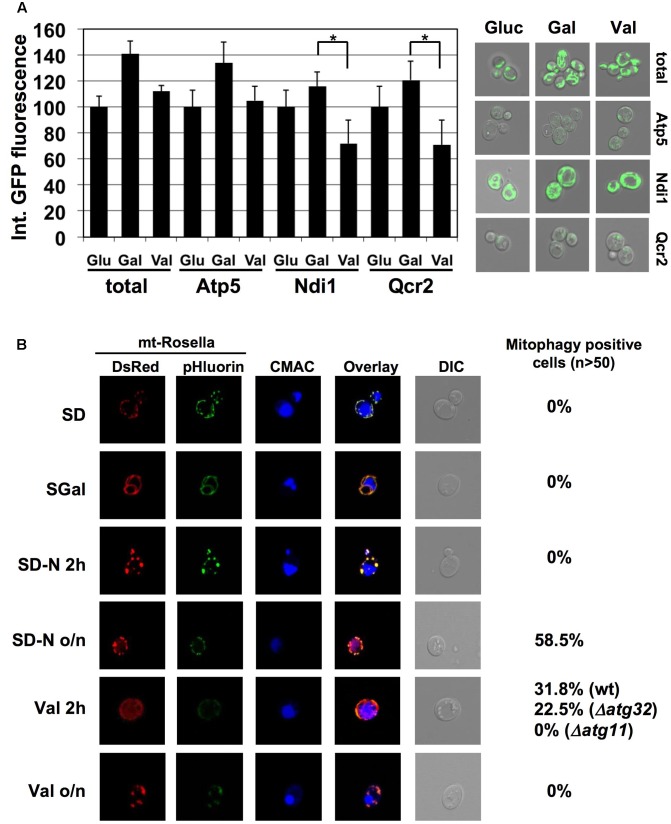
Valinomycin damage induces ETC specific mitophagy in yeast. (A) GFP fluorescence from the indicated ETC subunits or from mt-GFP was quantified upon fermentative growth (Glu) or partially respiratory growth without (Gal) or after treatment for 2 h with 4 μM valinomycin (Val). The mean of the integrated fluorescence intensity acquired from flattened z-stack images for >50 cells was calculated in one experiment. Data are shown as mean values and the standard error from two independent experiments. Asterisks mark a significant signal reduction (p < 0.05) according to the Students t-test. Representative micrographs are depicted at the right. (B) Valinomycin rapidly induces mitophagy in yeast cells. The mitophagy indicator Rosella was used in the indicated yeast strains. Cells were grown in selective glucose containing (SD) or galactose containing (SGal) media. Galactose grown cells were additionally subjected to N-starvation or valinomycin treatment (4 μM) for 2 h or over night as indicated. mtRosella was visualized by dsRed or pHluorin fluorescence, vacuoles were visualized with CMAC. The percentage of mitophagy positive cells is indicated at the right.